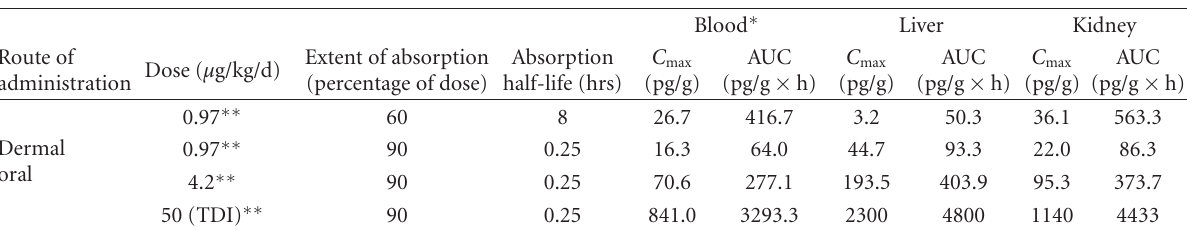
Table 2: BPA: Simulation results comparing of oral and dermal exposure. Results are given as C max (pg/g) and AUC (pg/g × h) in blood, liver, and kidney after dermal (extent of absorption 60% of the dose), and oral (extent of absorption 90% of the dose) administration. The external oral doses are identical with the external dermal dose (0.97 μ g/kg/d), a dose estimated by FAO/WHO (4.2 μ g/kg/d) as the upper level estimate and a dose at the tolerated daily intake (TDI) (50 μ g/kg/d). BPA undergoes first pass in the liver. The first pass in the liver produces a lower concentration in the systemic circulation ( C max and AUC in blood) compared to values after the dermal administration despite identical doses and a lower extent of absorption through skin as compared to the oral absorption. In contrast, C max and AUC in the liver are higher after oral as compared to the dermal exposure. Dermal dose ( μ g/kg/d) of BPA which corresponds to the concentration di ff erence between blood concentrations published by Sajiki et al., 1999 [25] and by Padmanabhan et al., 2008 [26] and the estimated oral dose by FAO/WHO, 2010. The blood concentration of BPA in a person who has ingested BPA at the upper level of oral exposure (4.2 μ g/kg/d) as calculated by FAO/WHO is 70.6pg/mL. Sajiki et al., 1999 [25] has measured a mean blood concentration of 330pg/mL and Padmanabhan et al., 2008 [26], a mean blood concentration of 5900 pg/mL. We calculated the di ff erence of the blood concentrations measured by Sajiki et al. and by Padmanabhan et al. [25, 26] and the modelled blood concentration caused by an oral dose of 4.2 μ g/kg/d. We then modelled the dermal dose which would be necessary to produce the concentration corresponding to the di ff erence between measured and modelled concentration. It can be seen that this dose (9.4 and 211.8 μ g/kg/d, resp.) is 10 to 200 fold higher than the experimentally measured dose of 0.97 μ g/kg/d [27].